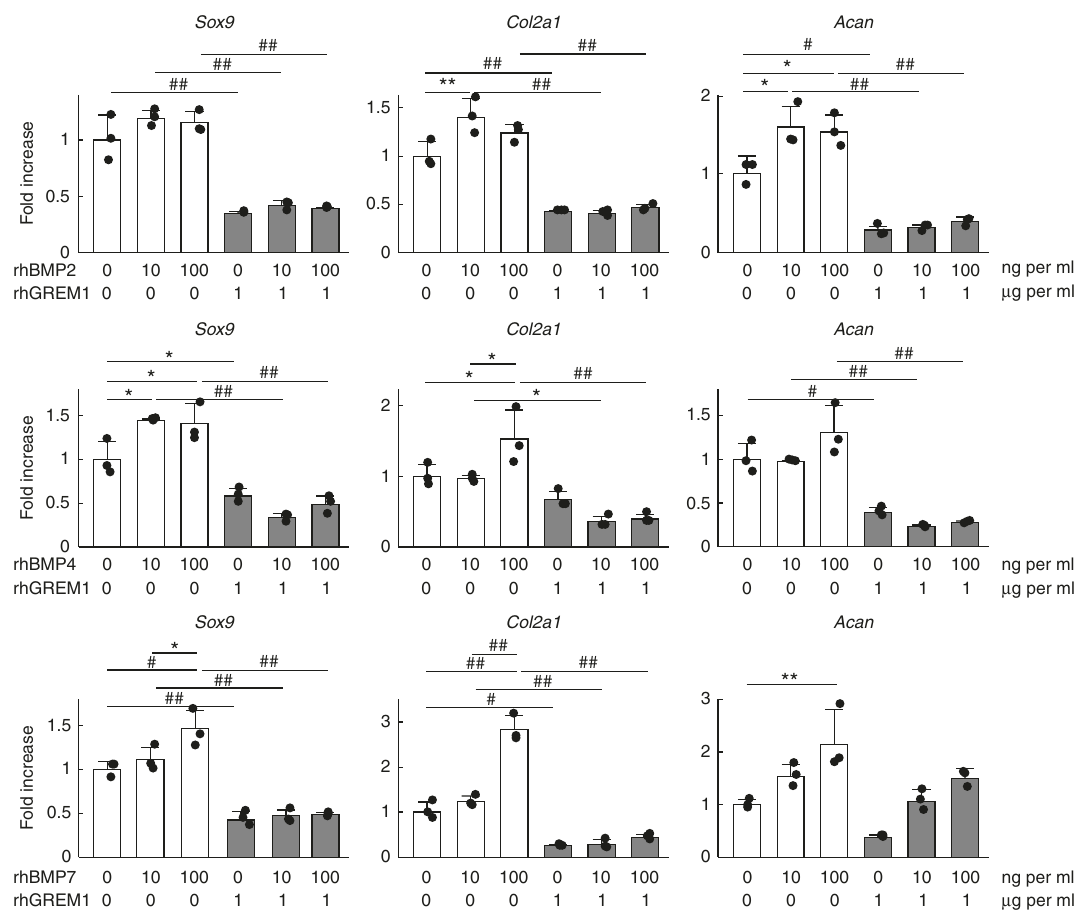
Fig. 6 Gremlin-1 antagonizes the anabolic effects of BMPs. mRNA levels of Sox9 , Col2a1 and Acan in mouse primary chondrocytes treated with rhBMP2, 4, or 7, and rhGREM1 for 24 h. * P < 0.05, ** P < 0.01, # P < 0.005, # # P < 0.001 versus vehicle (one-way ANOVA test). All data are expressed as means ± SD of biologically independent three samples per